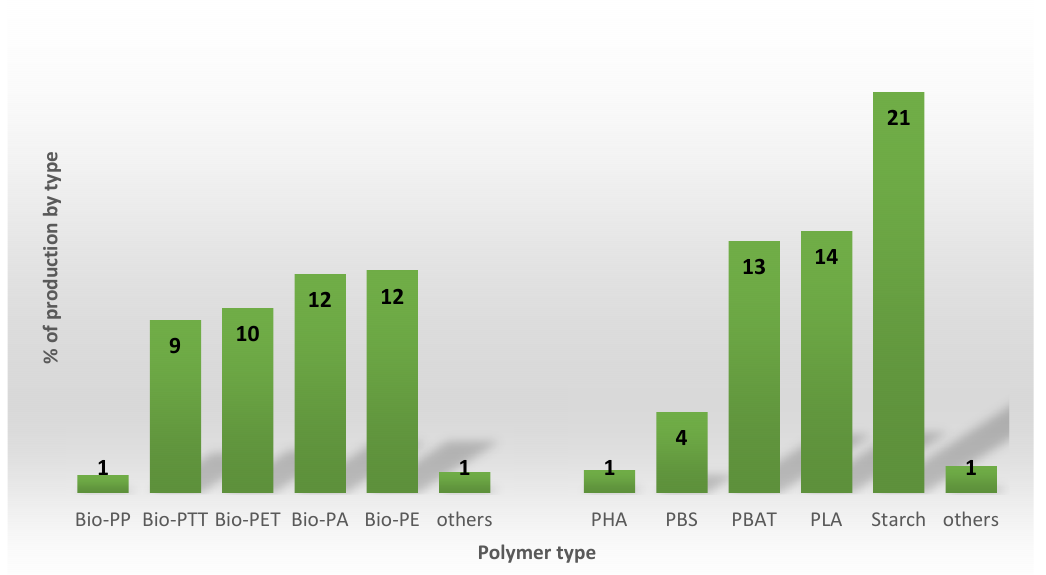
Figure 4. Percent (%) of global bio-based plastics production, by type.